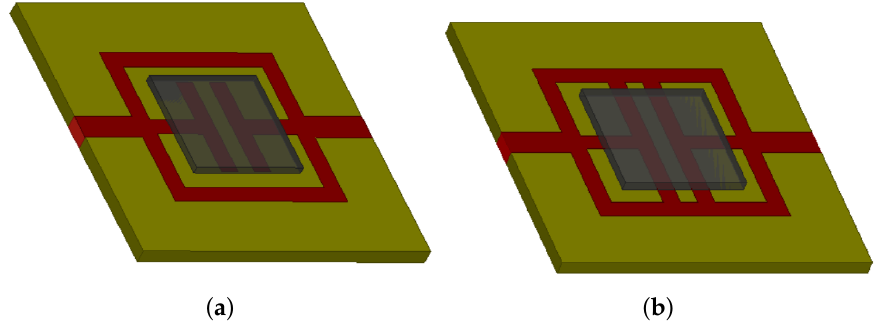
Figure 20. Schema of the two considered sensors with T-shaped stubs: ( a ) parallel stub (PS) and ( b ) parallel stub loop